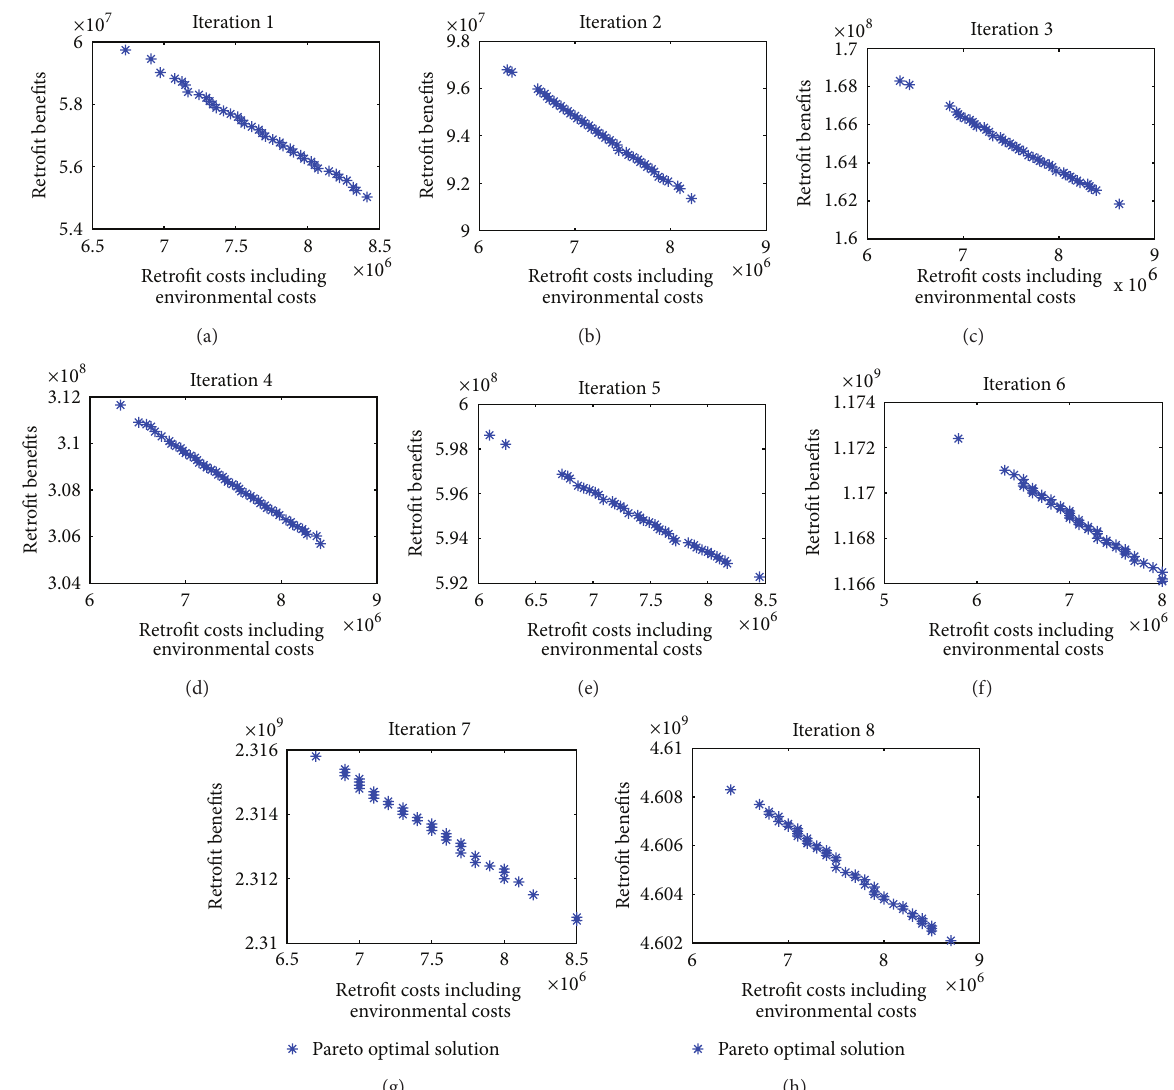
Figure 9: Iterative results of Pareto optimal solutions in 8